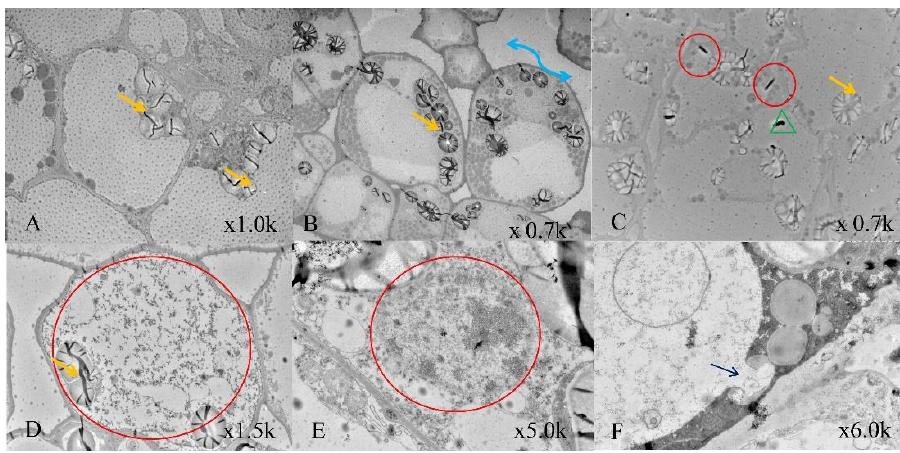
Figure 5. TEM analysis of cells of Agrobacterium -inoculated somatic embryos. ( A ) Control cells with normal internal structures, the cell wall and starch granules (yellow arrows) were evident and